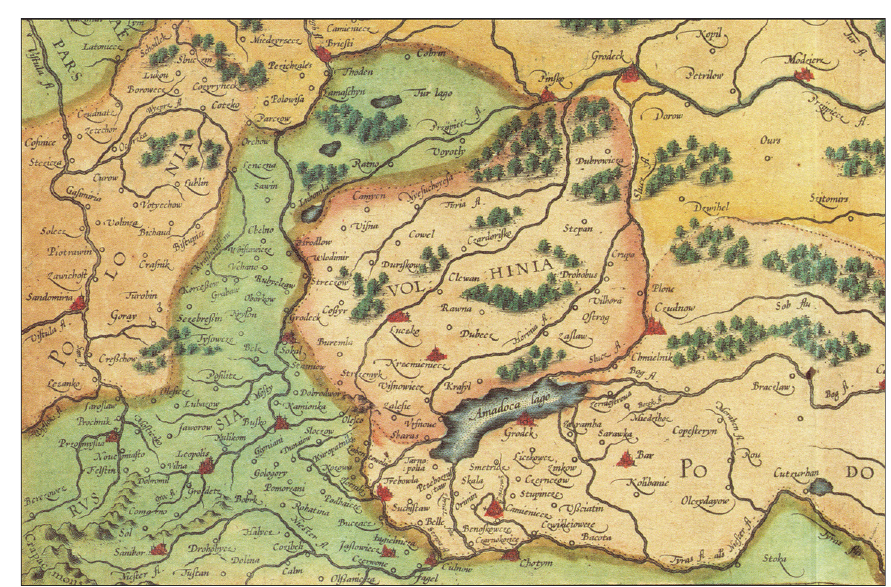
Fig. 4. Part of the map of Lithuania by G. Mercator